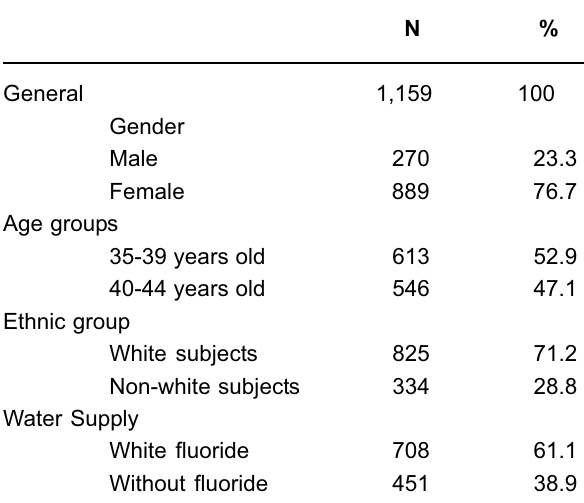
TABLE 1- Number and percentage of subjects according to gender, age group, ethnic group and fluoridated water status. Southeastern state of São Paulo,